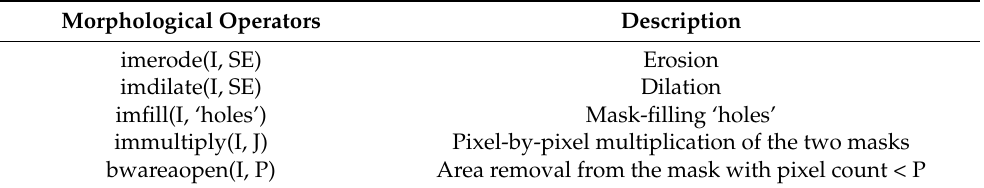
Table 2. Morphological MATLAB operators. Note that the parameters I and J are masks, SE is the structuring element and P is a pixel count value.